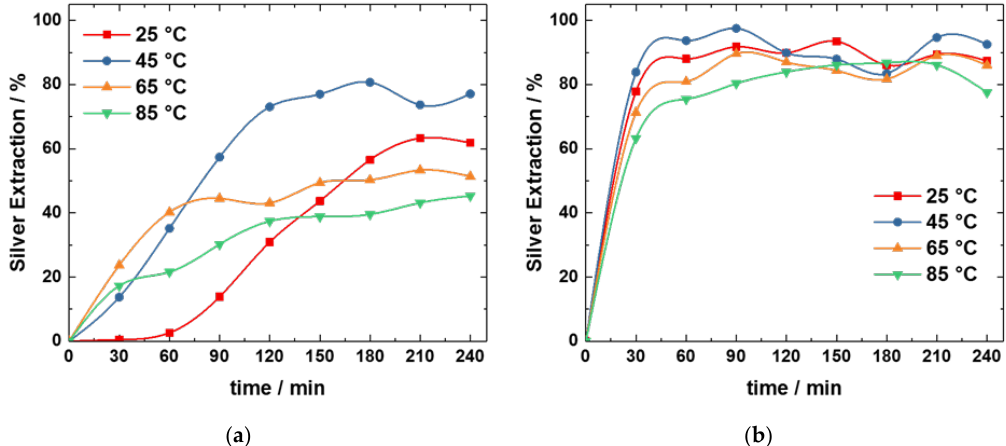
Figure 5. Silver extraction at different temperatures ( a ) without and ( b ) with the addition of hydrogen peroxide.